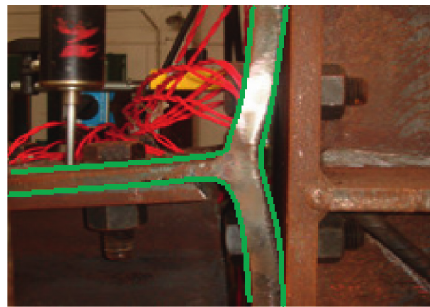
∈ 5 , 10 , 20 , 40 , 60 { } mm; Δ con I